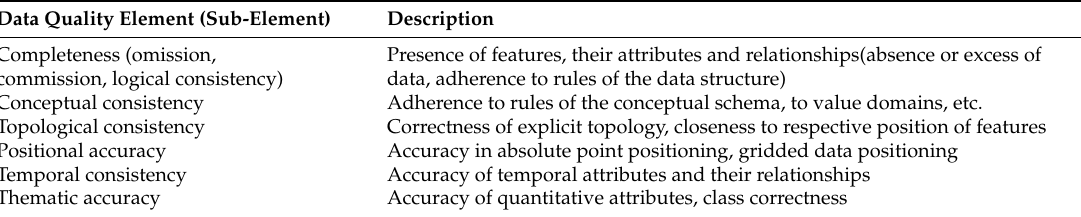
Table 2. Metadata for representing the quality of spatial data (ISO